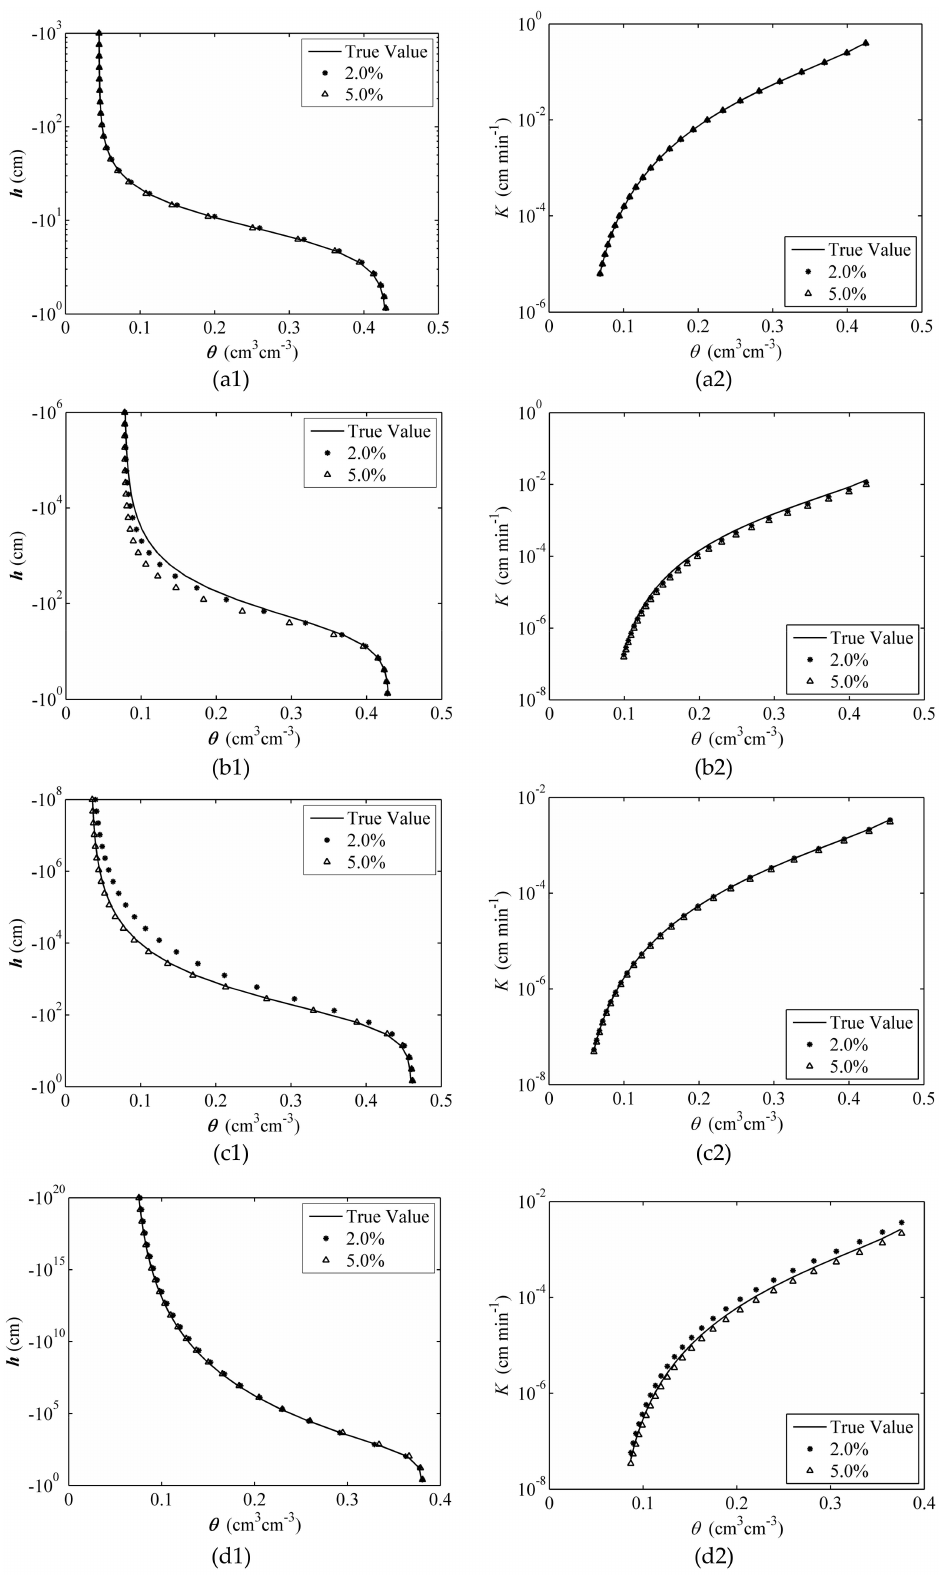
Figure 10. Comparison of SWRCs ( a1 , b1 , c1 , d1 ) and conductivity curves ( a2 , b2 , c2 , d2 ) with random errors and system errors for various treatments with objective function ψ ( Q ) (random error (RE), 2.0%, circle; random error, 5.0%, triangle; true value, line): ( a ) Sand; ( b ) Loam; ( c ) Silt; and ( d ) Clay.